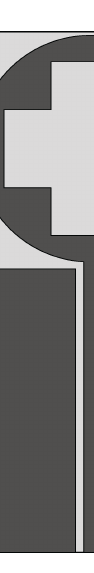
Figure 13. CPW-fed circular slotted planar monopole antenna for microwave imaging systems (redrawn from [69]). Dark gray metal face and light gray dielectric